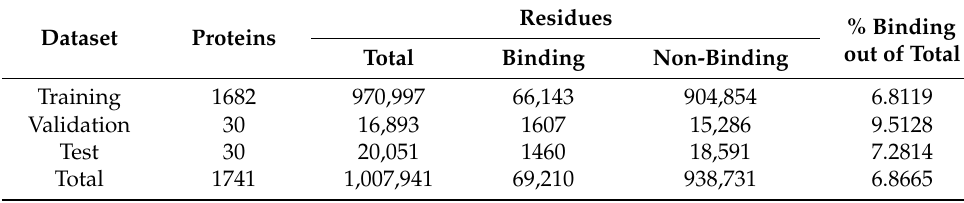
Table 1. The datasets for training, validation, and testing are shown in the